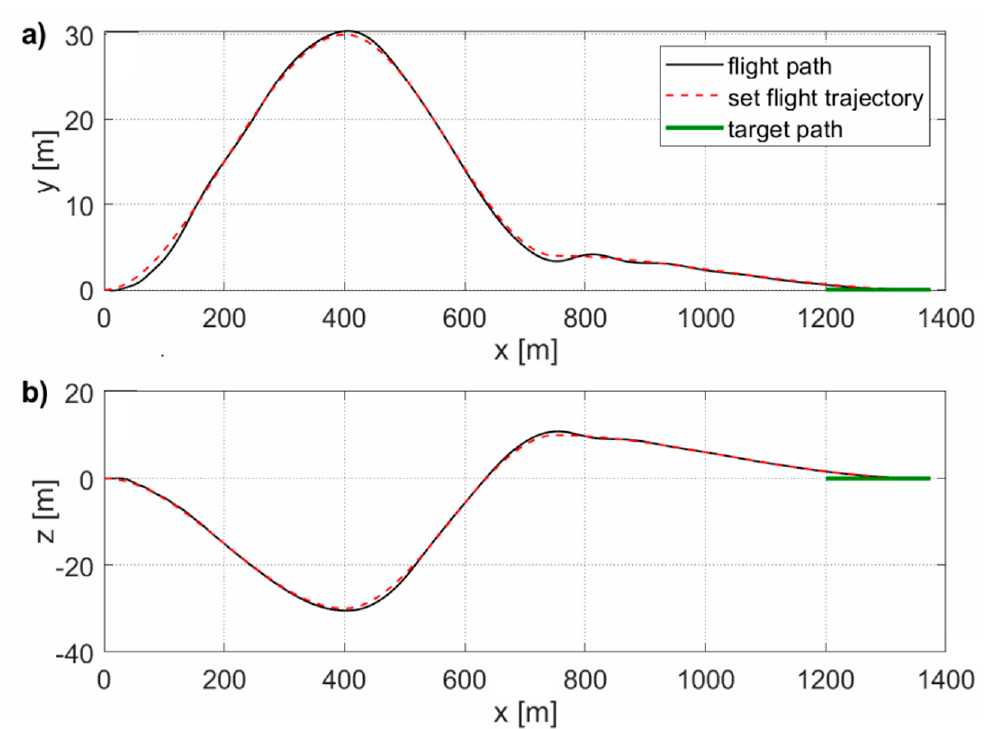
Figure 5. The performed trajectory in the 3D space.